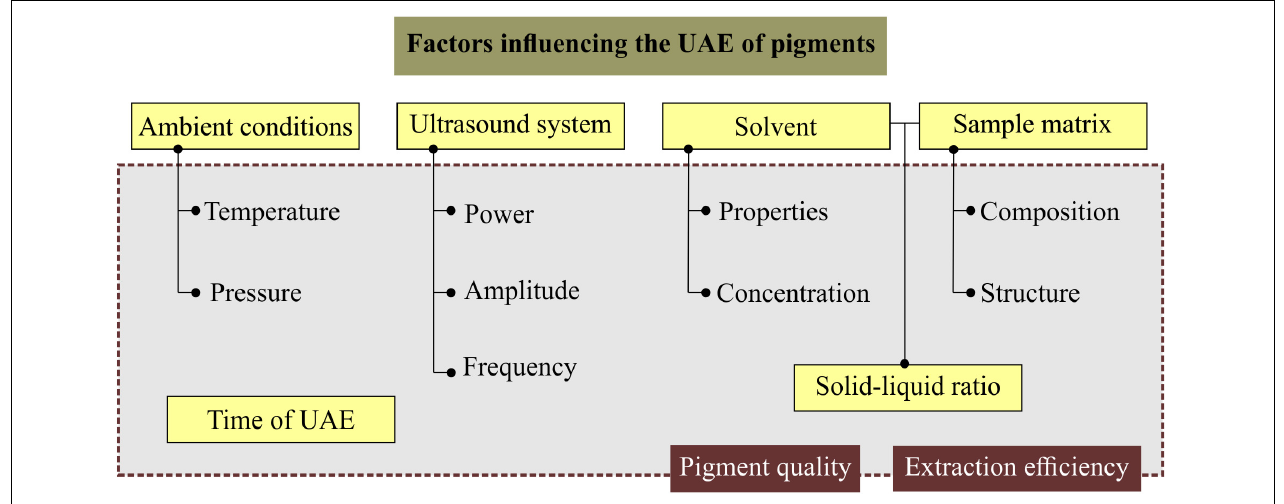
FIGURE 3 | Factors and parameters that influence the UAE process and impact extraction efficiency and pigment